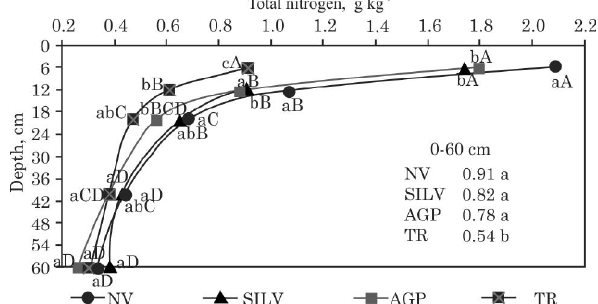
Figure 5. Total N contents in a typical ortic Chromic Luvisol under natural vegetation (NV) and silvopastoral (SILV), agrosilvopastoral (AGP) and traditional agricultural (TR) systems after